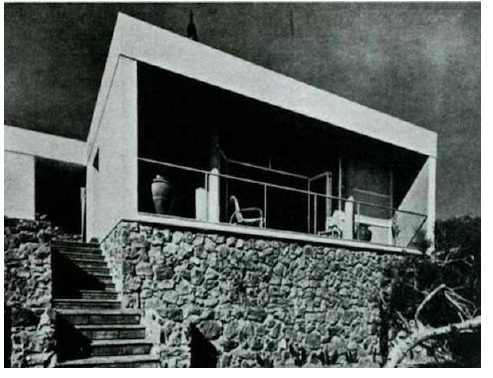
Figure 11. Week End house in ‘Garraf Barcelona’.